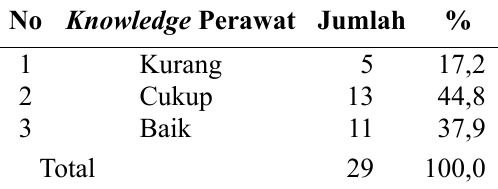
Tabel 2. Kinerja pendokumentasian